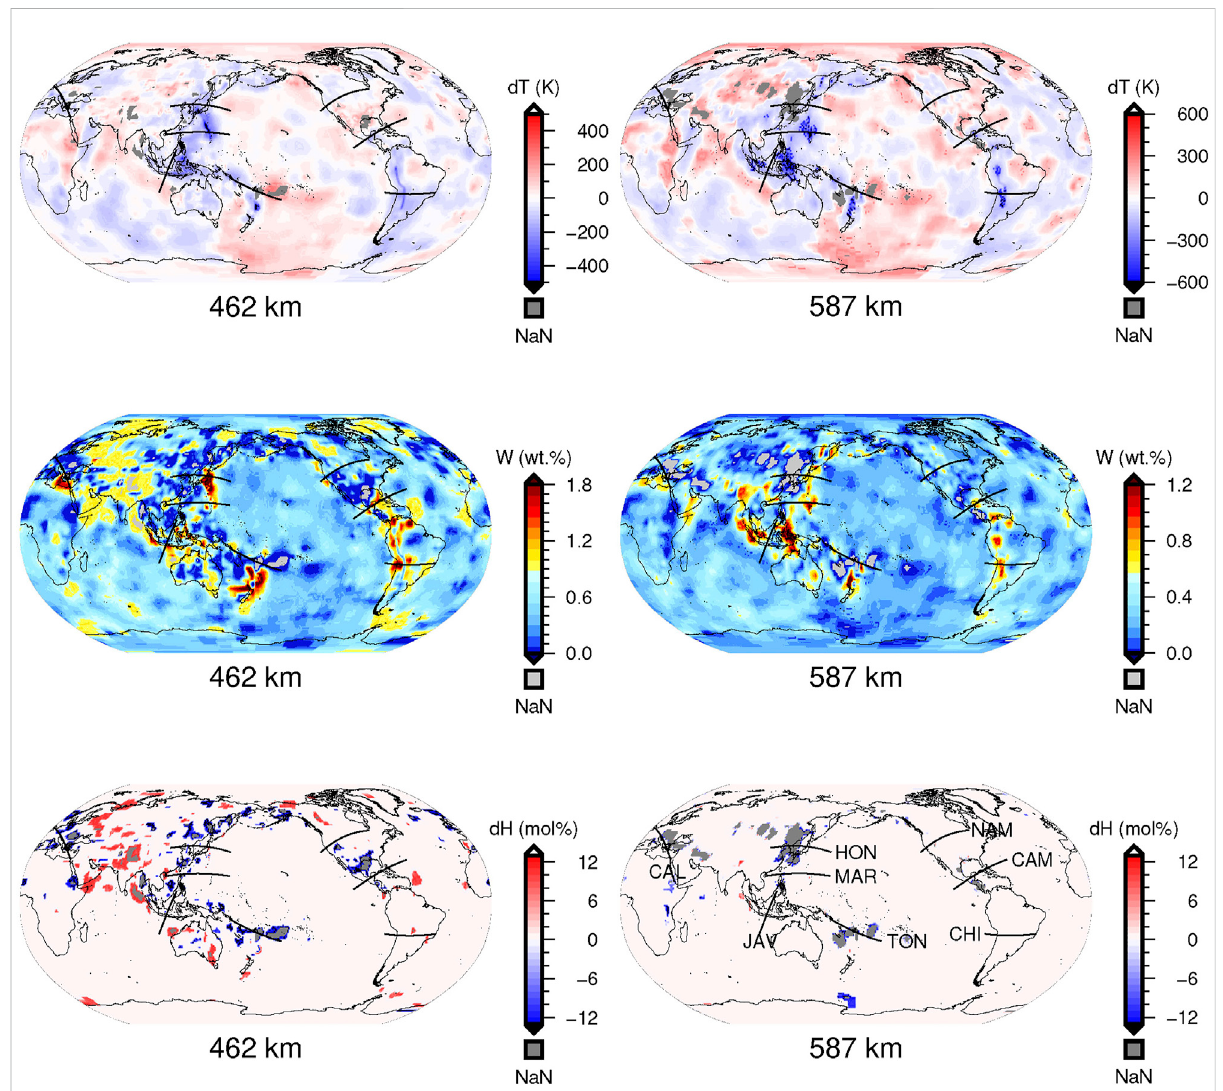
FIGURE 5 Distributions of temperature anomalies, water contents and harzburgite anomalies in the upper MTZ (462 km) and the lower MTZ (587 km). Only the optimal solutions with a mis fi t less than 0.2% are displayed, and those with an error greater than 0.2% (NaN) are marked in gray color. Eight black lines represent the subducting directions of slabs in eight subduction